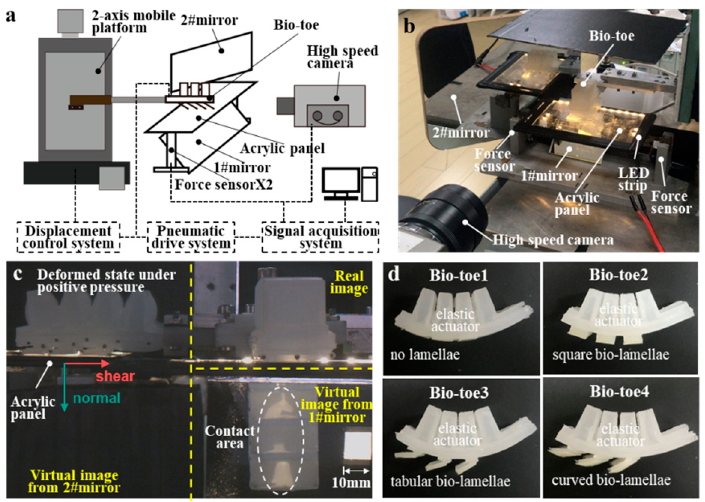
Figure 5. ( a ) Diagram of the synchronous testing platform of adhesive contact state and mechanics. ( b ) Synchronous testing platform. ( c ) A frame from the video captured by the high-speed camera. ( d ) Prototypes of the four bio-toes.